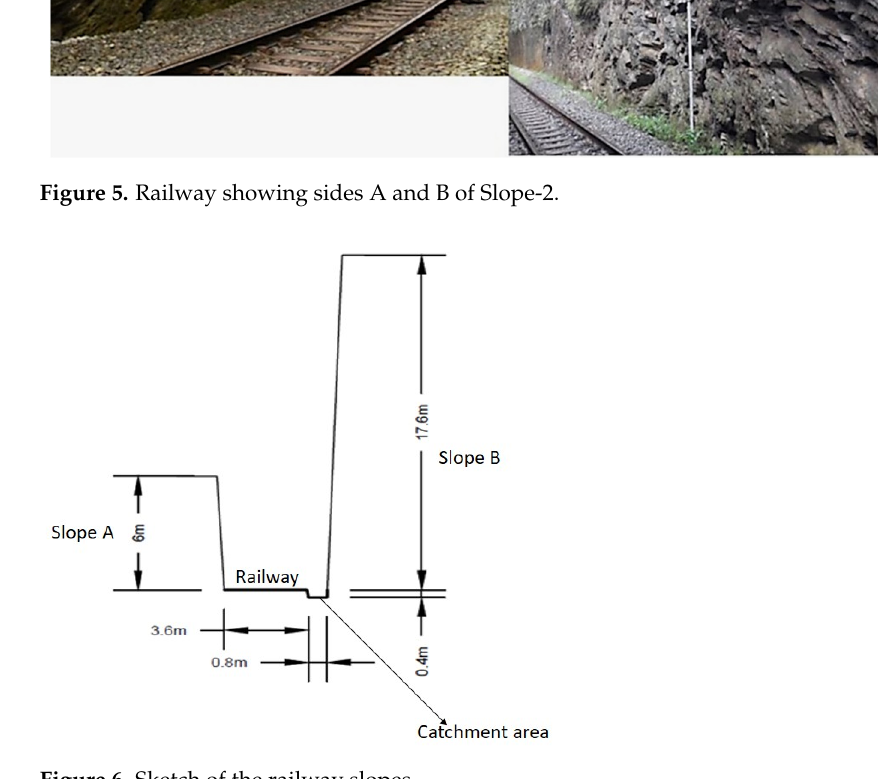
Table 9. Characteristics of the discontinuity sets in Slope-2